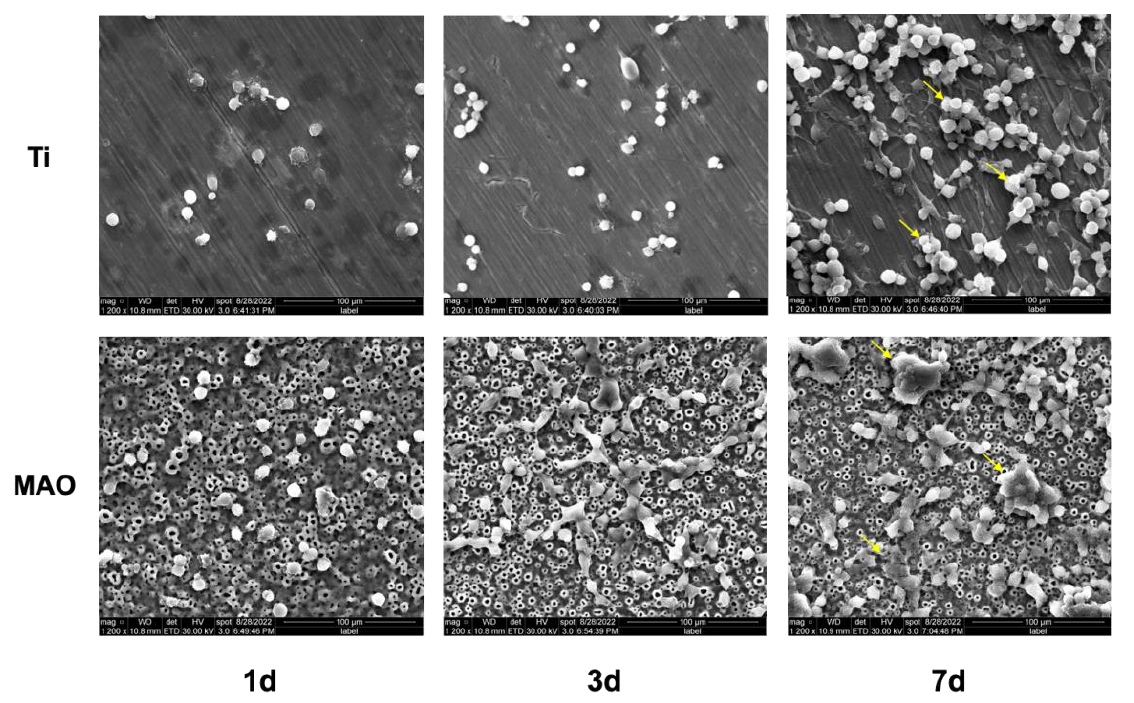
Figure 3. The quantity and morphology of Schwann cells on MAO and Ti surfaces on days 1, 3 and 7 of culture by SEM. 7 of culture by